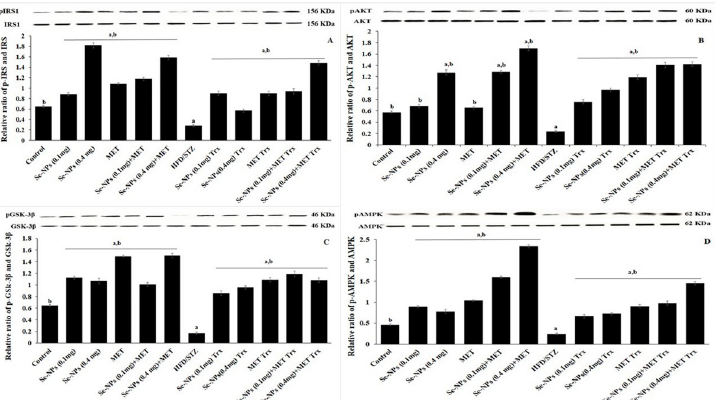
Fig 8. Western blot analyses show the expression levels of insulin signaling pathway. Liver anti IRS1, anti-IRS1 p Tyr612 , anti-AKT1 & anti-AKT1 p ser473 , anti-GSK-3 β & anti-GSK-3 β p Ser9 , anti-AMPK- α , anti-AMPK- α p T172 , protein levels were measured by western blot. The quantitative values were normalized to IRS1, AKT, GSK-3 β , and AMPK- α , respectively in liver tissue of HFD/STZ-induced rats and after treatment with Se-NPs and MET monotherapy and combined therapy. Values are mean ± SE (the mean of three assays). Significant changes (p < 0.01) with respect to control and HFD/STZ-experimental rats are expressed by the letters (a) and (b),